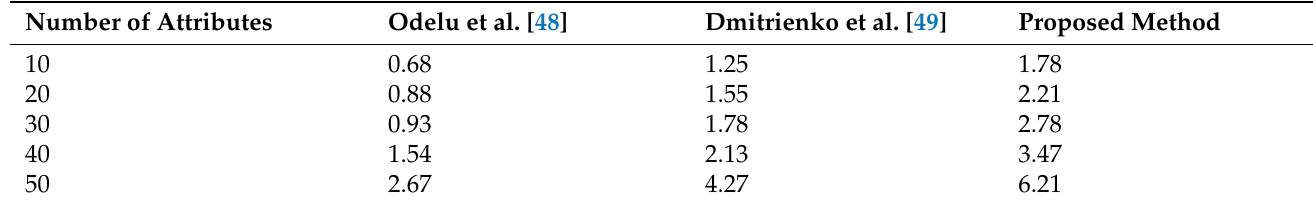
Figure 15. The execution time to crack the proposed system. Table 9. Execution Time to crack the proposed system.